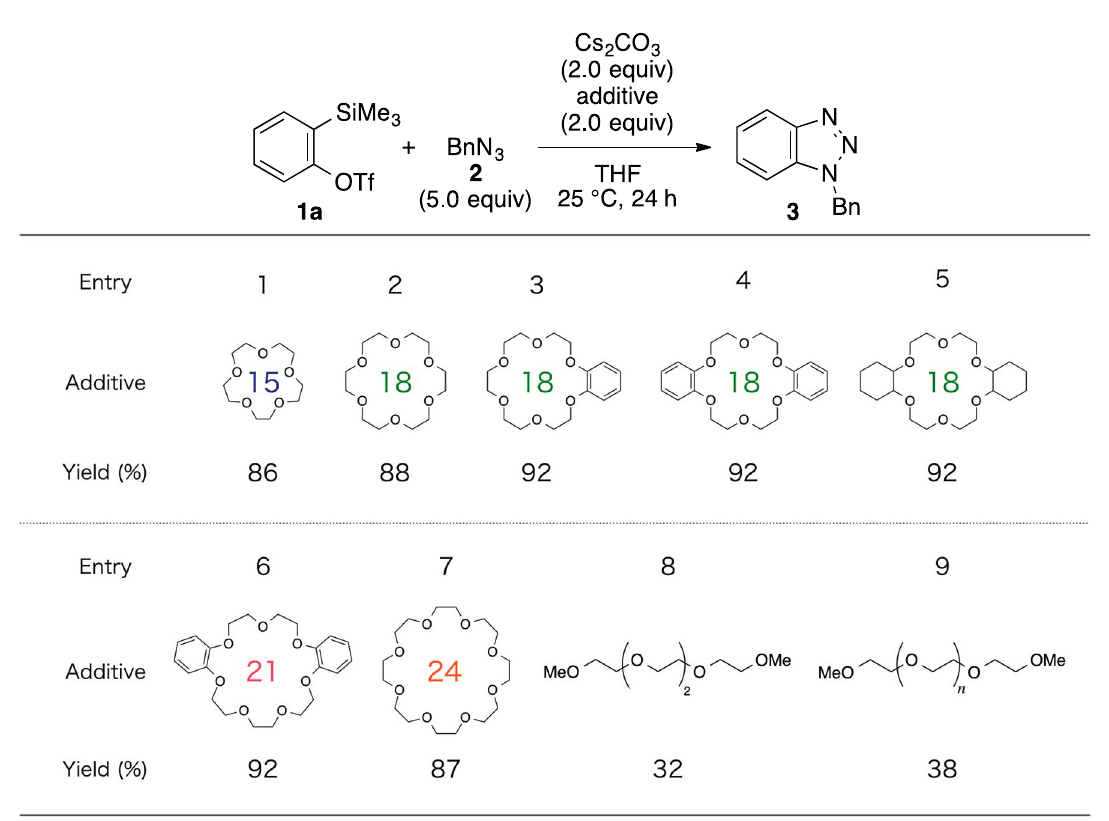
Figure 2. Efficiency of the reactions between 1a and 2 using cesium carbonate in combination with different ethers. Yields determined by 1 H-NMR